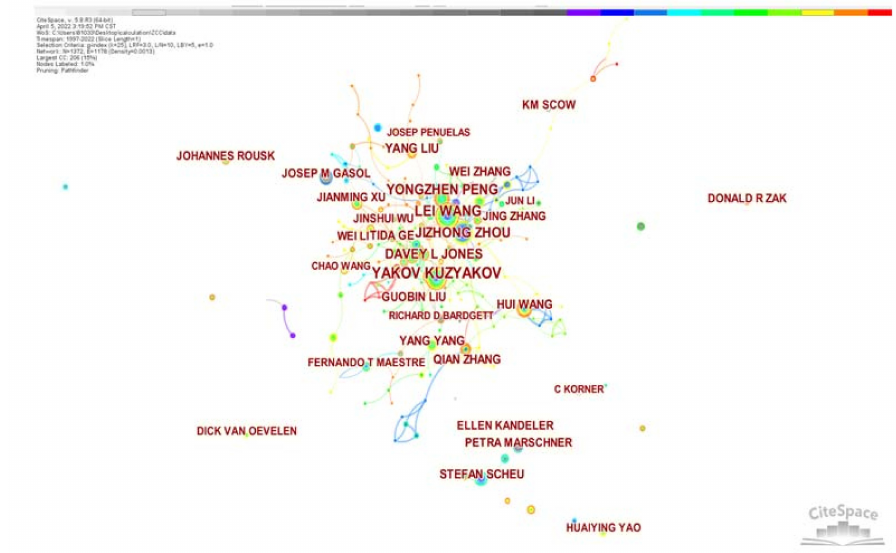
Figure 5. Knowledge map of co-authors of papers published on ZCC from 1997–2022.